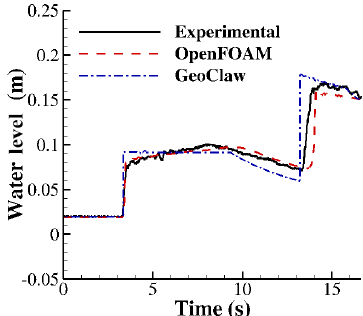
Figure 2. Time history of water level at 5 . 2m from the gate (center of the column) with the column